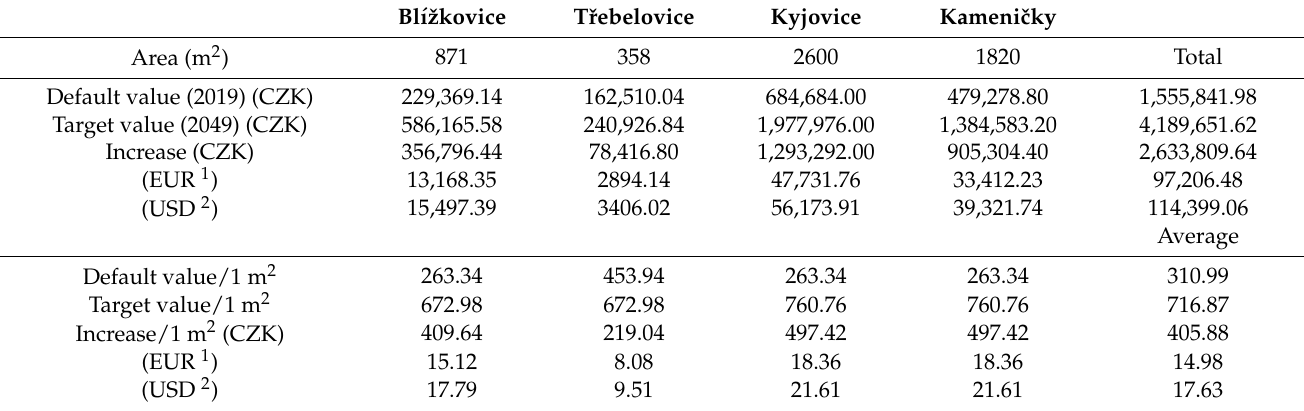
Table 3. The summary of total and average values of financial habitat